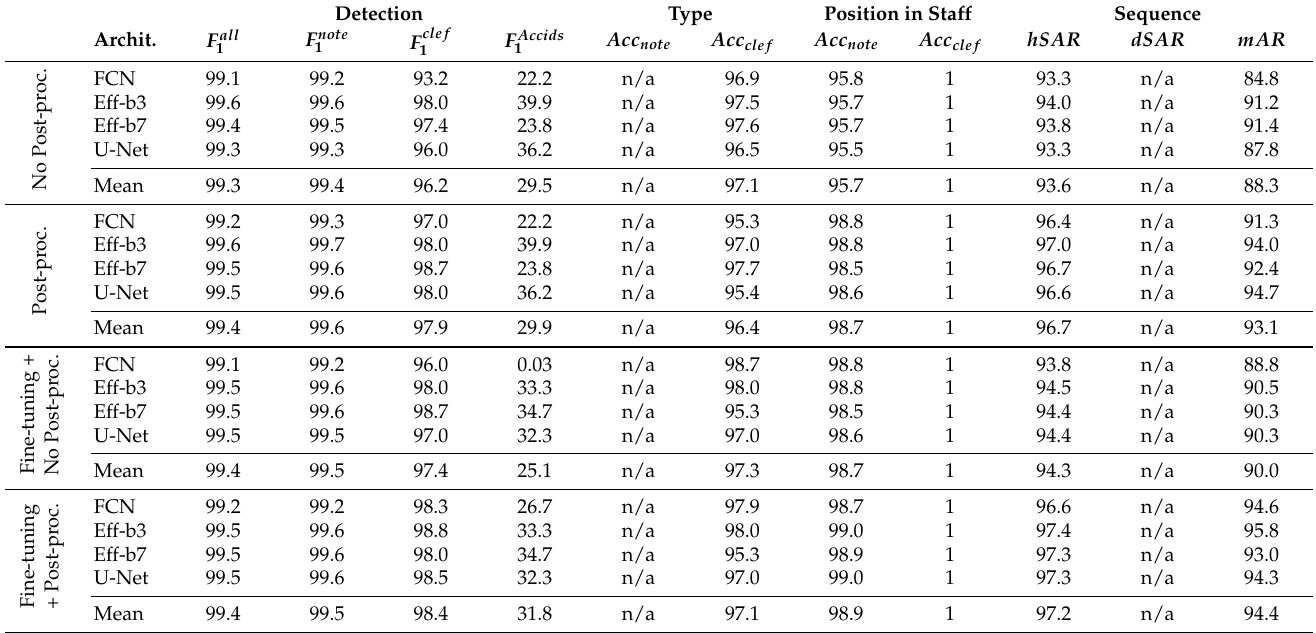
Table 6. In this experiment, training and evaluating was conducted only on the Pa904 dataset (all metrics in %). The mixed model of the previous experiment was optionally used for a document specific fine-tuning. This experiment is most similar to a real world scenario, where only a limited number of pages for training is available.